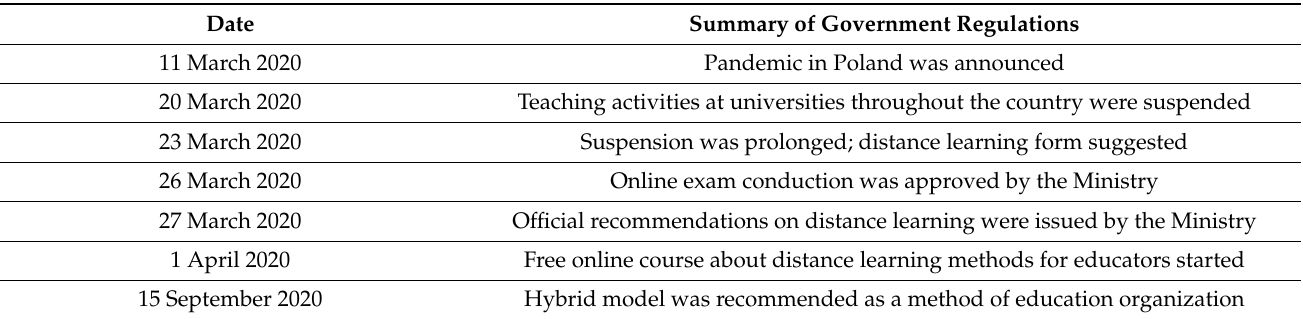
Table 2. Time-lined summary of the distance learning government regulations introduced in Poland at the beginning of the COVID-19